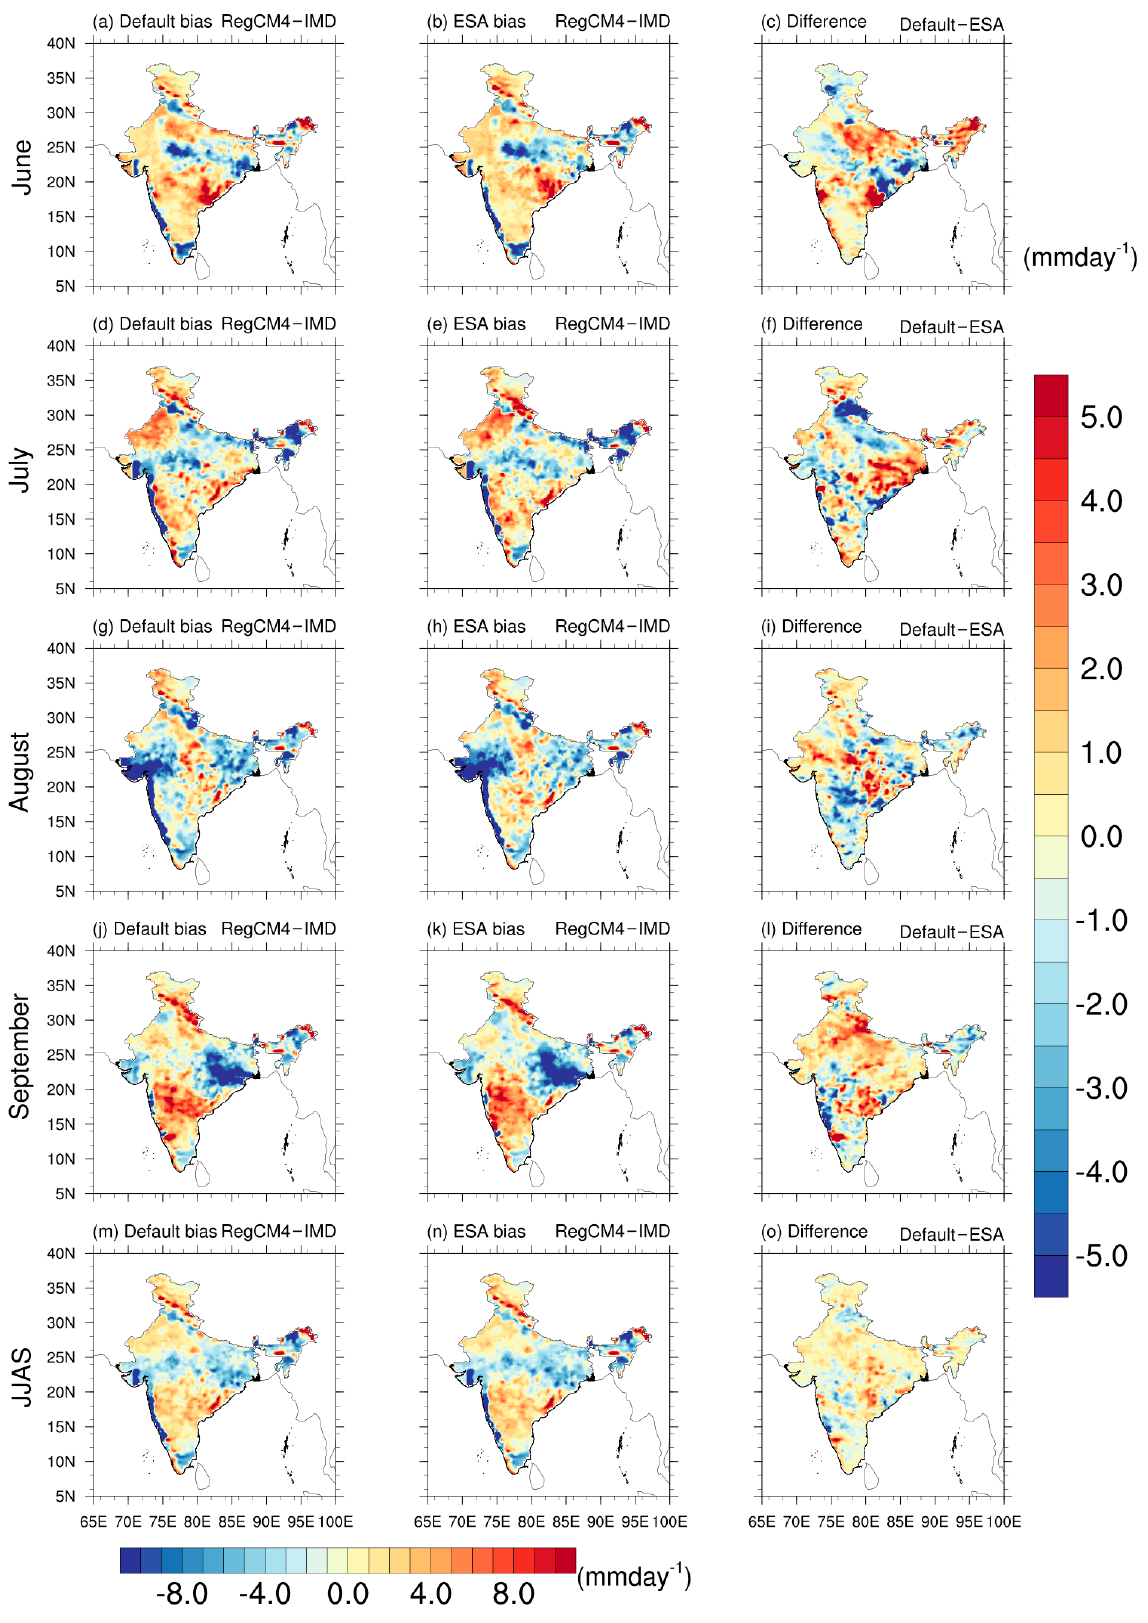
Figure 9. Same as Figure 8, but for the year 2011. Day ‐ to ‐ day variation of rainfall is an important aspect of ISM which controls the overall performance of the model throughout the season. Hence, daily rainfall variations